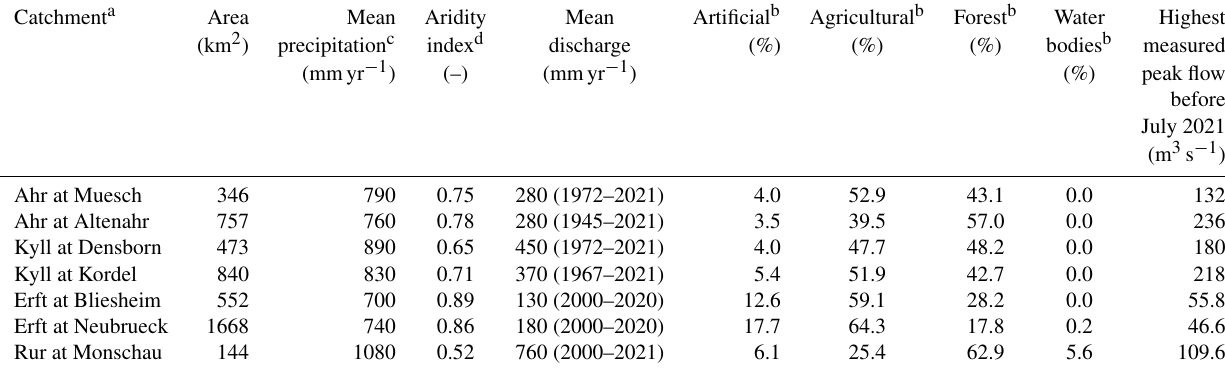
peak flow before July